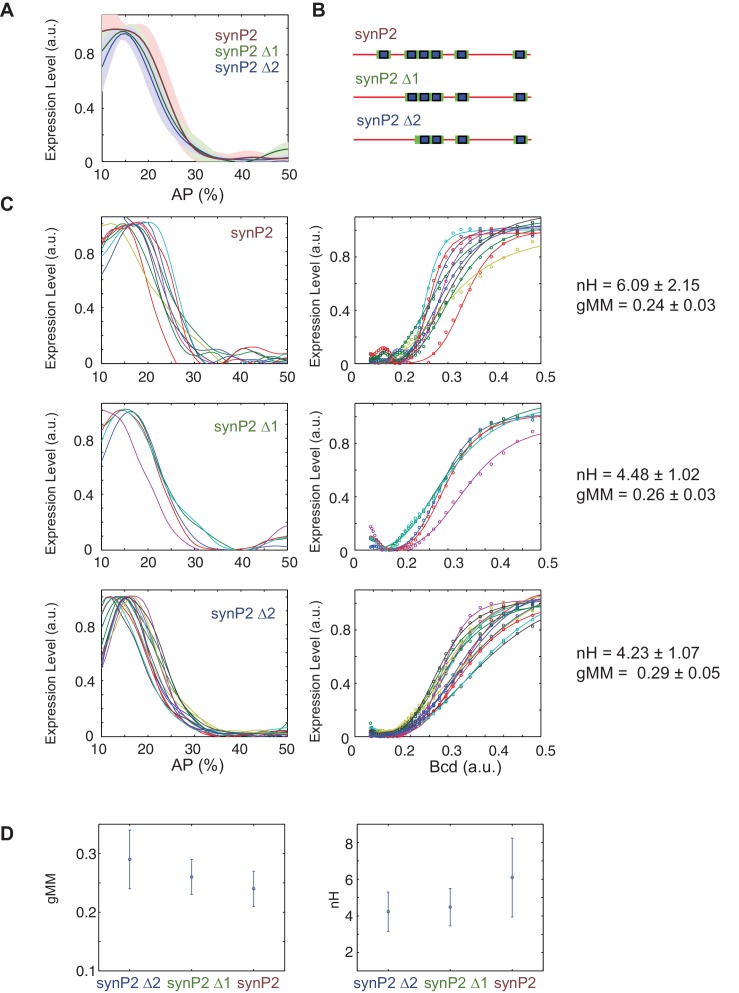
Removing Bcd TFBS from SynHbP2 reporter construct.We deleted binding sites from a version of SynHbP2 that contained 12 bp of endogenous sequence flanking each Bcd binding site. (A) Average expression profile from SynP2 deletion constructs color coded as in B. Shaded area indicates standard deviation. (B) Schematics of SynhbP2-reporter constructs with binding site sequentially removed. (C) (left) mRNA expression profiles obtained from embryos that carry transgenic reporter constructs. (right) Bcd/LacZ GRFs for each construct in (B). Dots represent measured value and lines show a fit to Hill function. (D) Hill Coefficient (nH) obtained from each reporter construct, reflecting the shape of the GRF. The generalised Michaelis-Menten constant obtained from each construct, reflecting the location of the expression boundary.